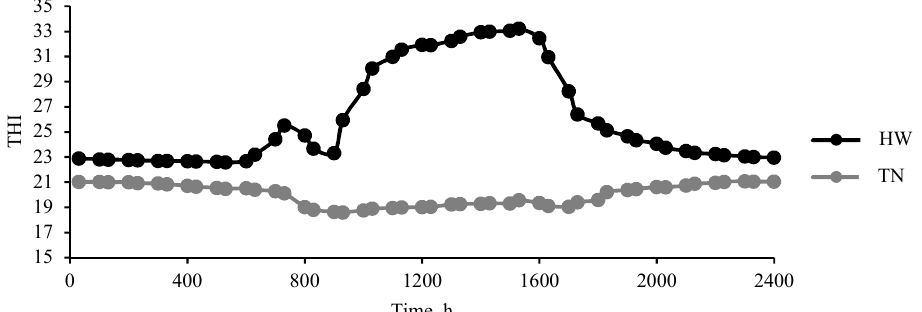
Figure 1. Average daily temperature humidity index (THI) recorded in the heatwave (HW) and the thermoneutral room (TN) during the experimental period. The average THI of the HW was 30.1 in the daytime and 23.9 in the nighttime (standard error difference of means = 0.55) and the THI of the TN was 19.8 (standard error difference of means = 0.67). THI < 22.2 = no heat stress, 22.2 to 23.3 = moderate heat stress, 23.3 to 25.6 = serve heat stress, >25.6 = extreme severe heat stress [3,13] .